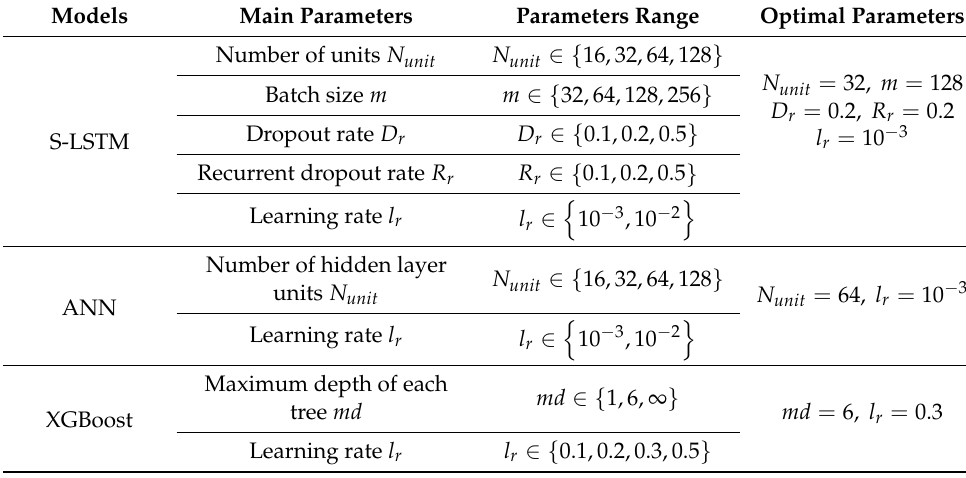
Table 4. Optimal parameters of